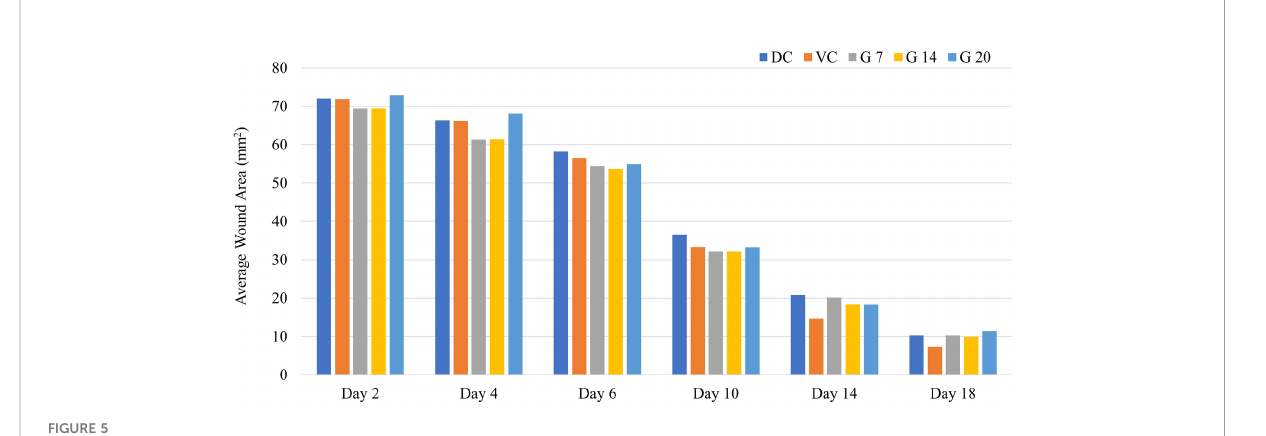
FIGURE 5 Day-wise wound area changes in the different treatment